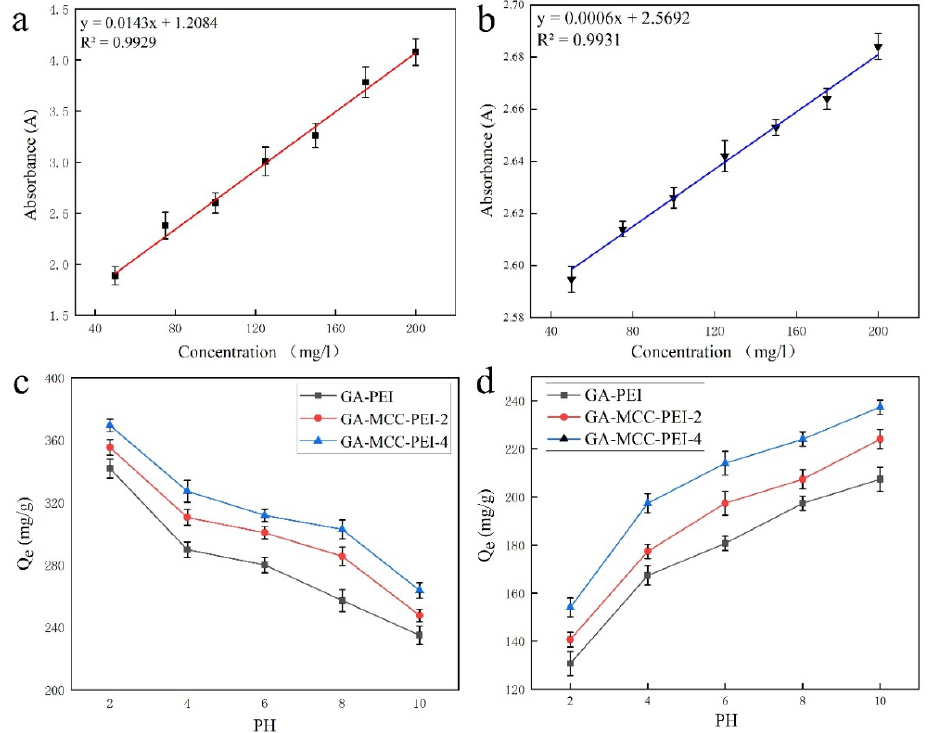
Figure 9. Standard curves of ( a ) amaranth and ( b ) methylene blue. Adsorption capacity curves of ( c , d ) GA-PEI, GA-MCC-PEI-2, and GA-MCC-PEI-4 under different pH conditions. Equilibrium absorption capacities for amaranth and methylene blue.